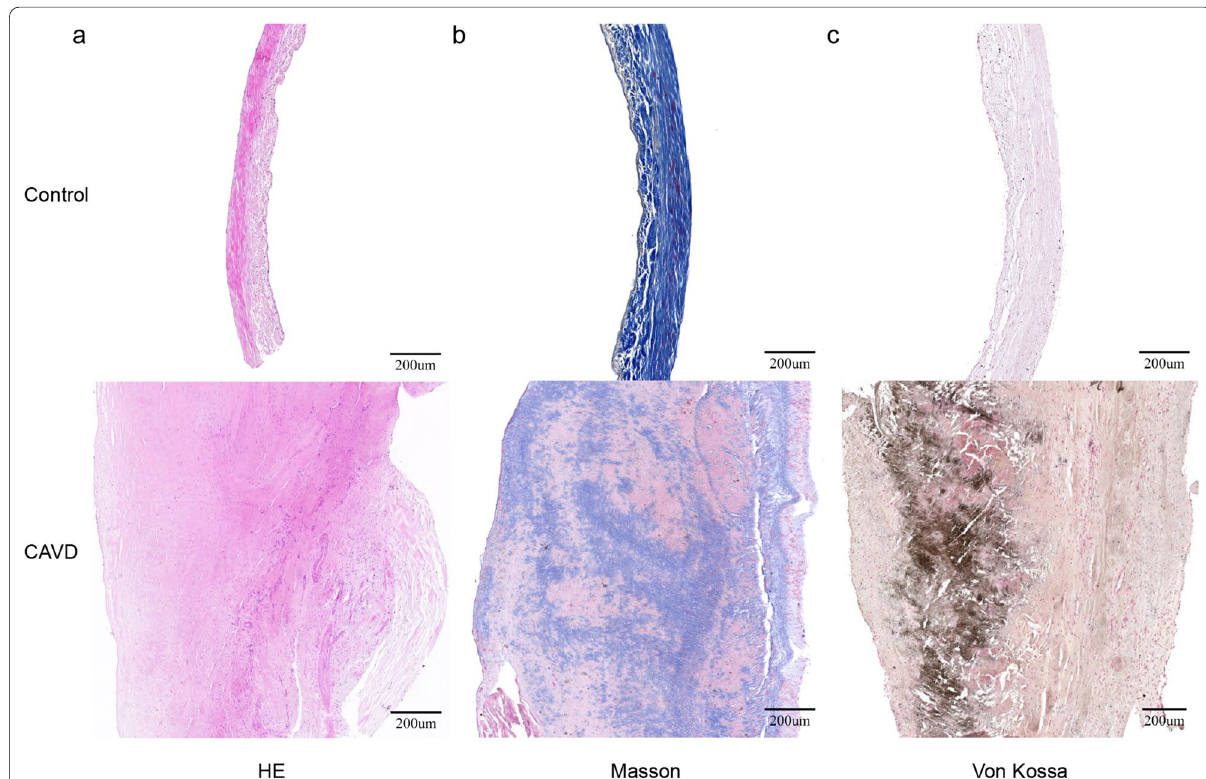
Fig. 1 Histochemical staining of aortic valves. a and b Hematoxylin–eosin (HE) and Masson’s trichrome staining showing valve thickening and collagen fiber hyperplasia; c Von Kossa staining showing calcium deposition in valves, black indicates calcium deposition. Scale bar, 200 μm; CAVD calcific aortic valve